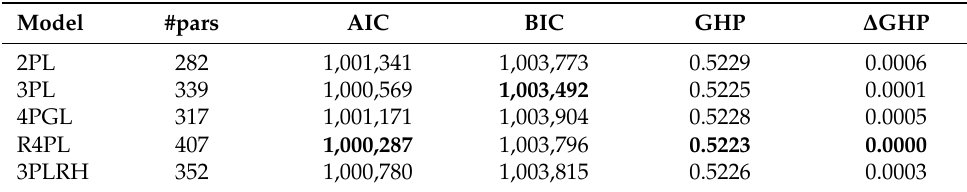
Table 4. PIRLS 2016 reading: Model comparison of different scaling models based on Akaike infor- mation criterion (AIC), Bayesian information criterion (BIC) and Gilula–Haberman penalty (GHP). Model #pars AIC BIC GHP ∆ GHP